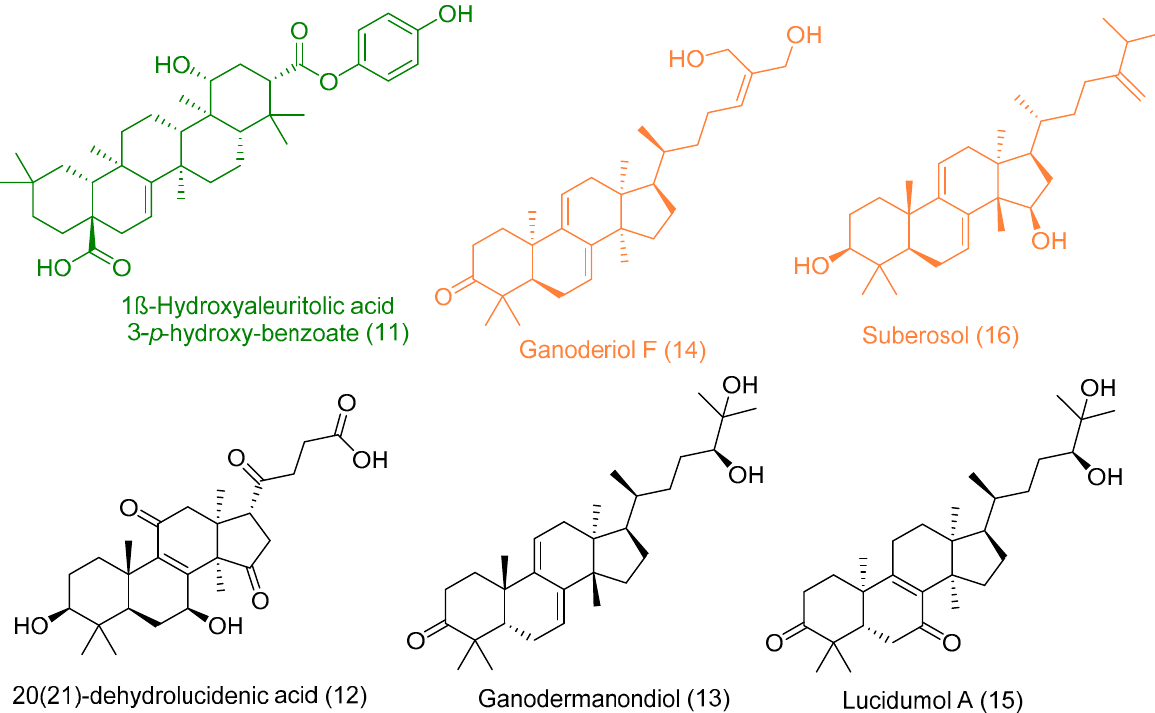
Figure 7. Top-scoring triterpenes retrieved from docking against both viral and human-based targets. Hits for 5 targets (Green color), hits for 2 targets (Orange color), and hits for only one target (Black color).